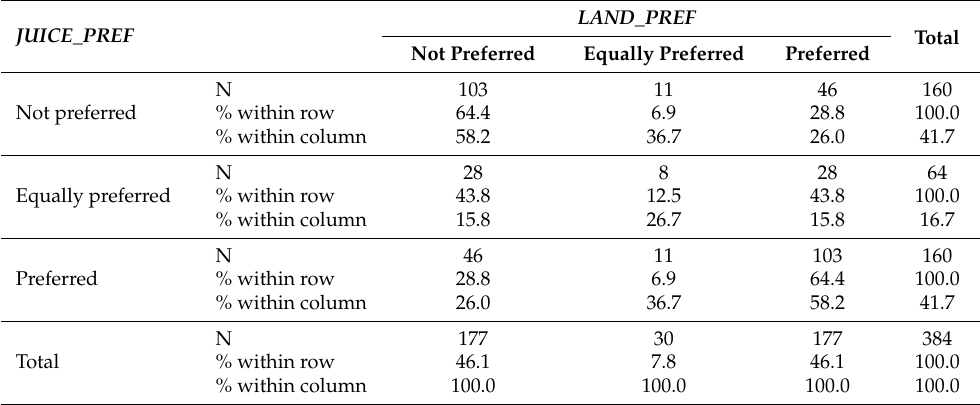
Table 3. Effect of overall liking and landscape aesthetic visual quality on the probability that the participants are willing to pay more for one of the tasted juices. JUICE _ PREF